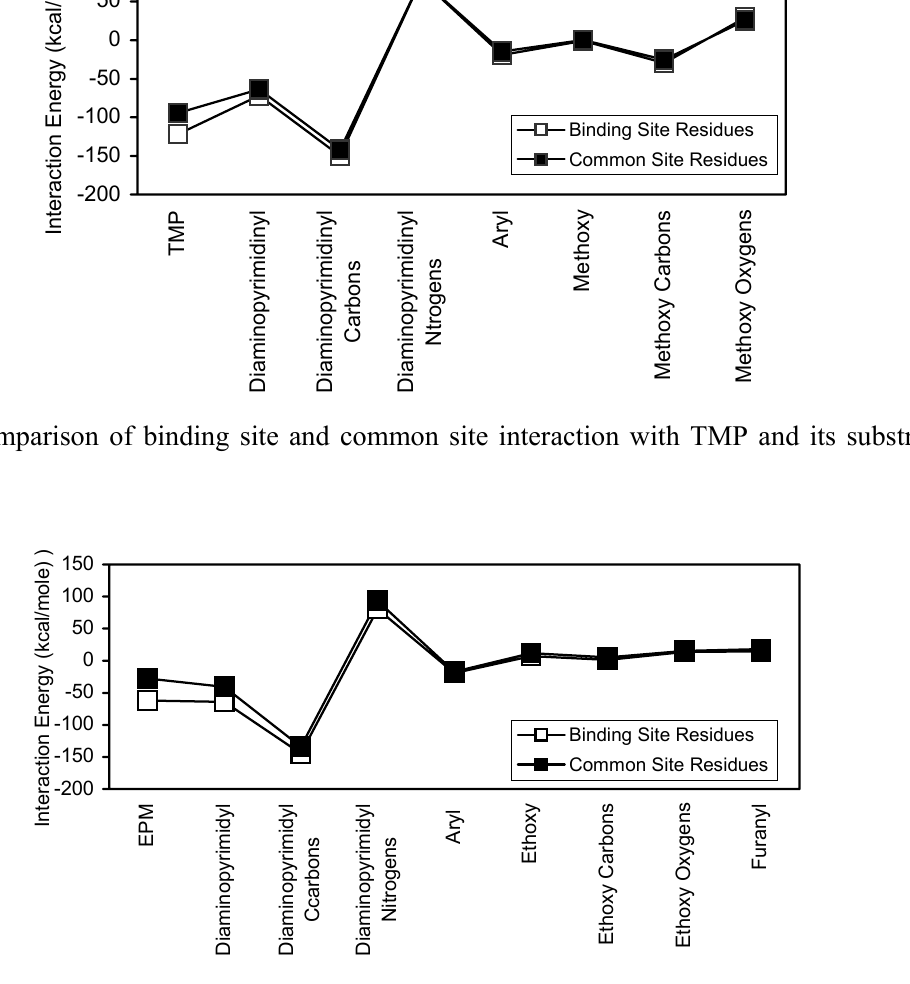
Figure 18 . Comparison of binding site and common site interaction with EPM and its substructural